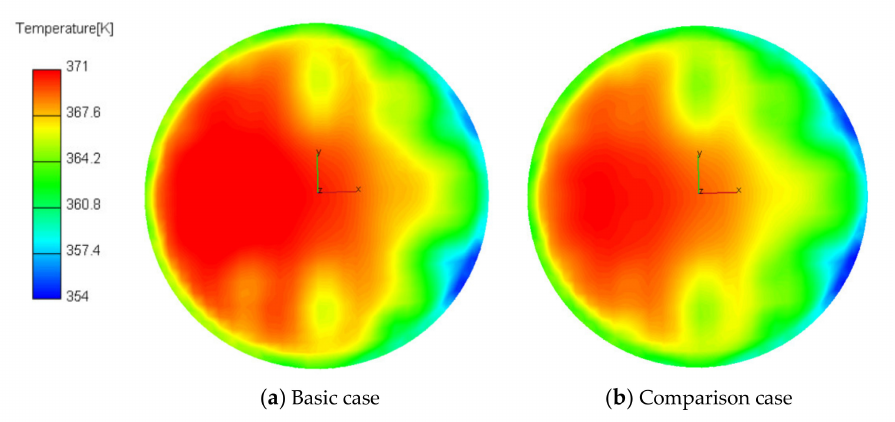
Figure 16. Contour of the outlet